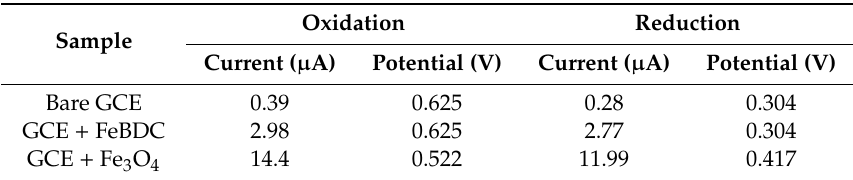
Table 1. Oxidation and Reduction Peak Current and Potential of bare GCE, FeBDC / GCE. Fe 3 O 4 / GCE in 3 mM of glucose and PBS of 0.1 M pH